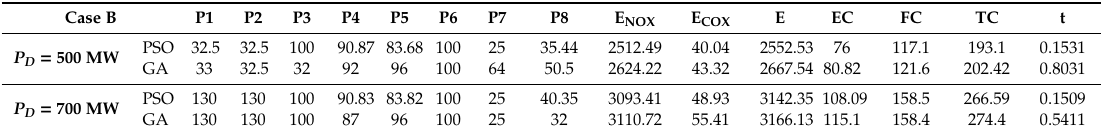
Table 4. The real-time simulation results of PSO and GA for Pakistani independent power plant (IPP) with P D = 500 MW and P D = 700 MW. 23